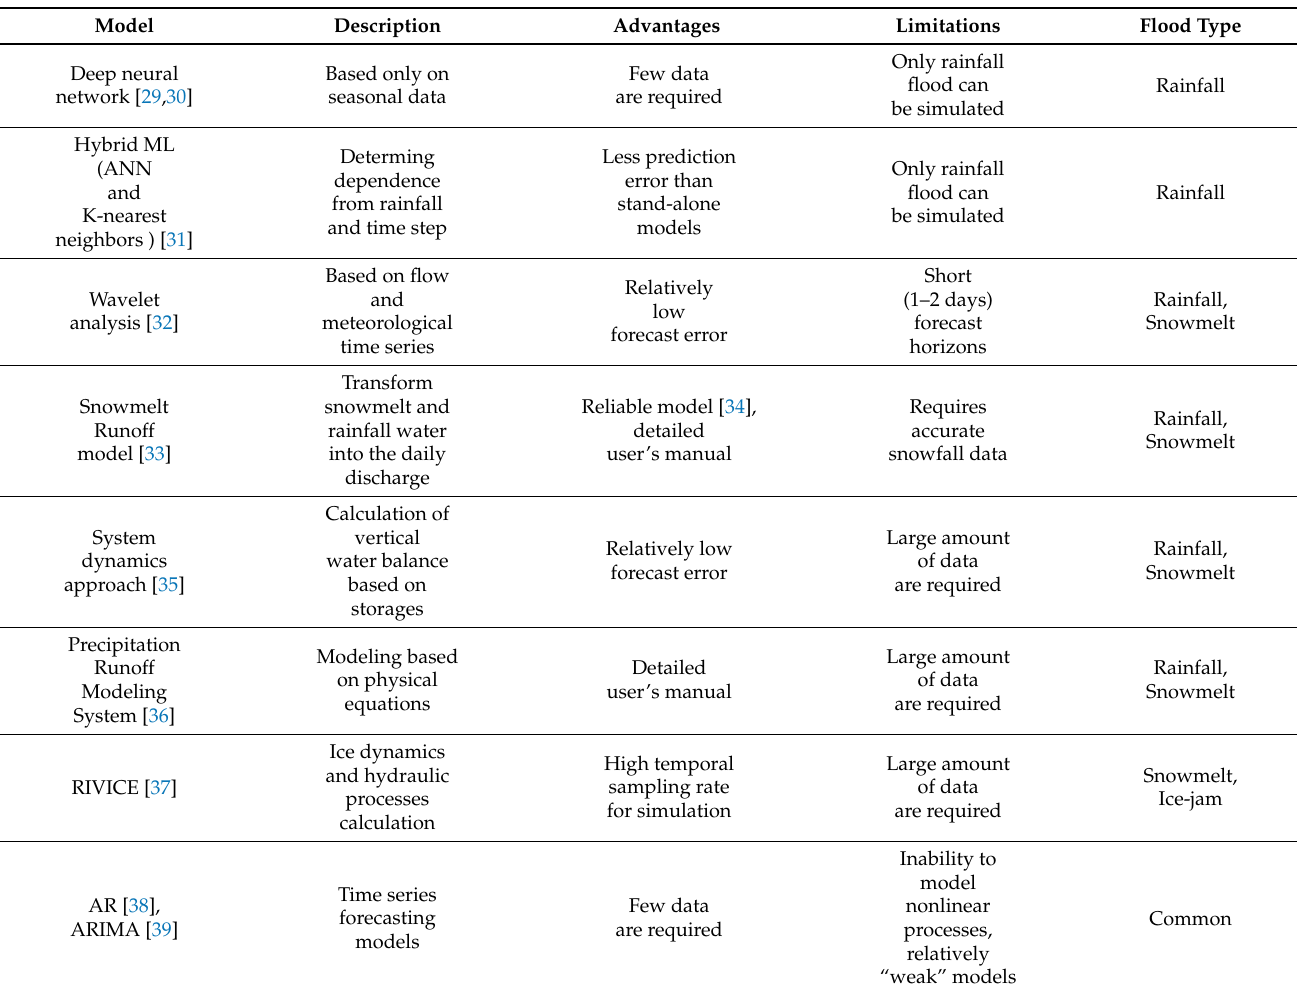
Table 1. Methods and models for flood forecasting. The “Flood type” column shows the flood factors that the model is capable of